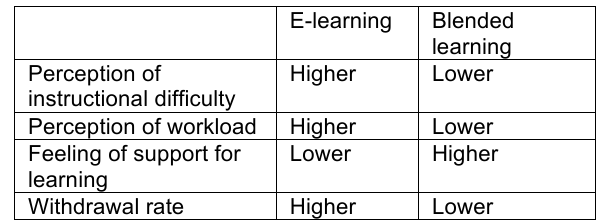
Table 1. Some differences between e-learning and blended learning settings